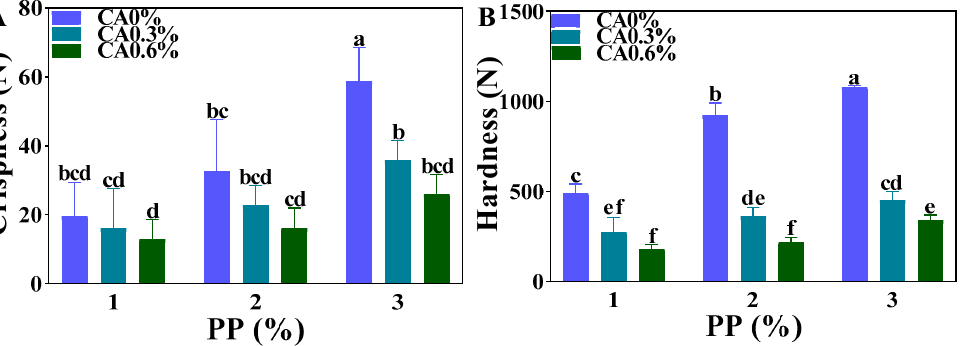
Figure 7. The texture of the heat-treated product: ( A ) is the crispness of heat-treated product; ( B ) is the hardness of heat-treated product; different marked letters in each figure indicated statistically significant differences in data in the figure ( p < 0.05) .